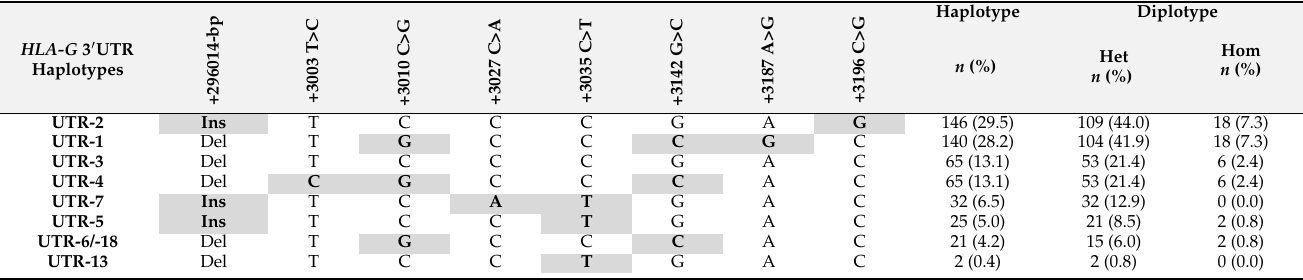
Table 2. HLA-G 3 (cid:48) UTR haplotypes: frequencies distributions in 248 eligible patients with mCRC. Haplotype